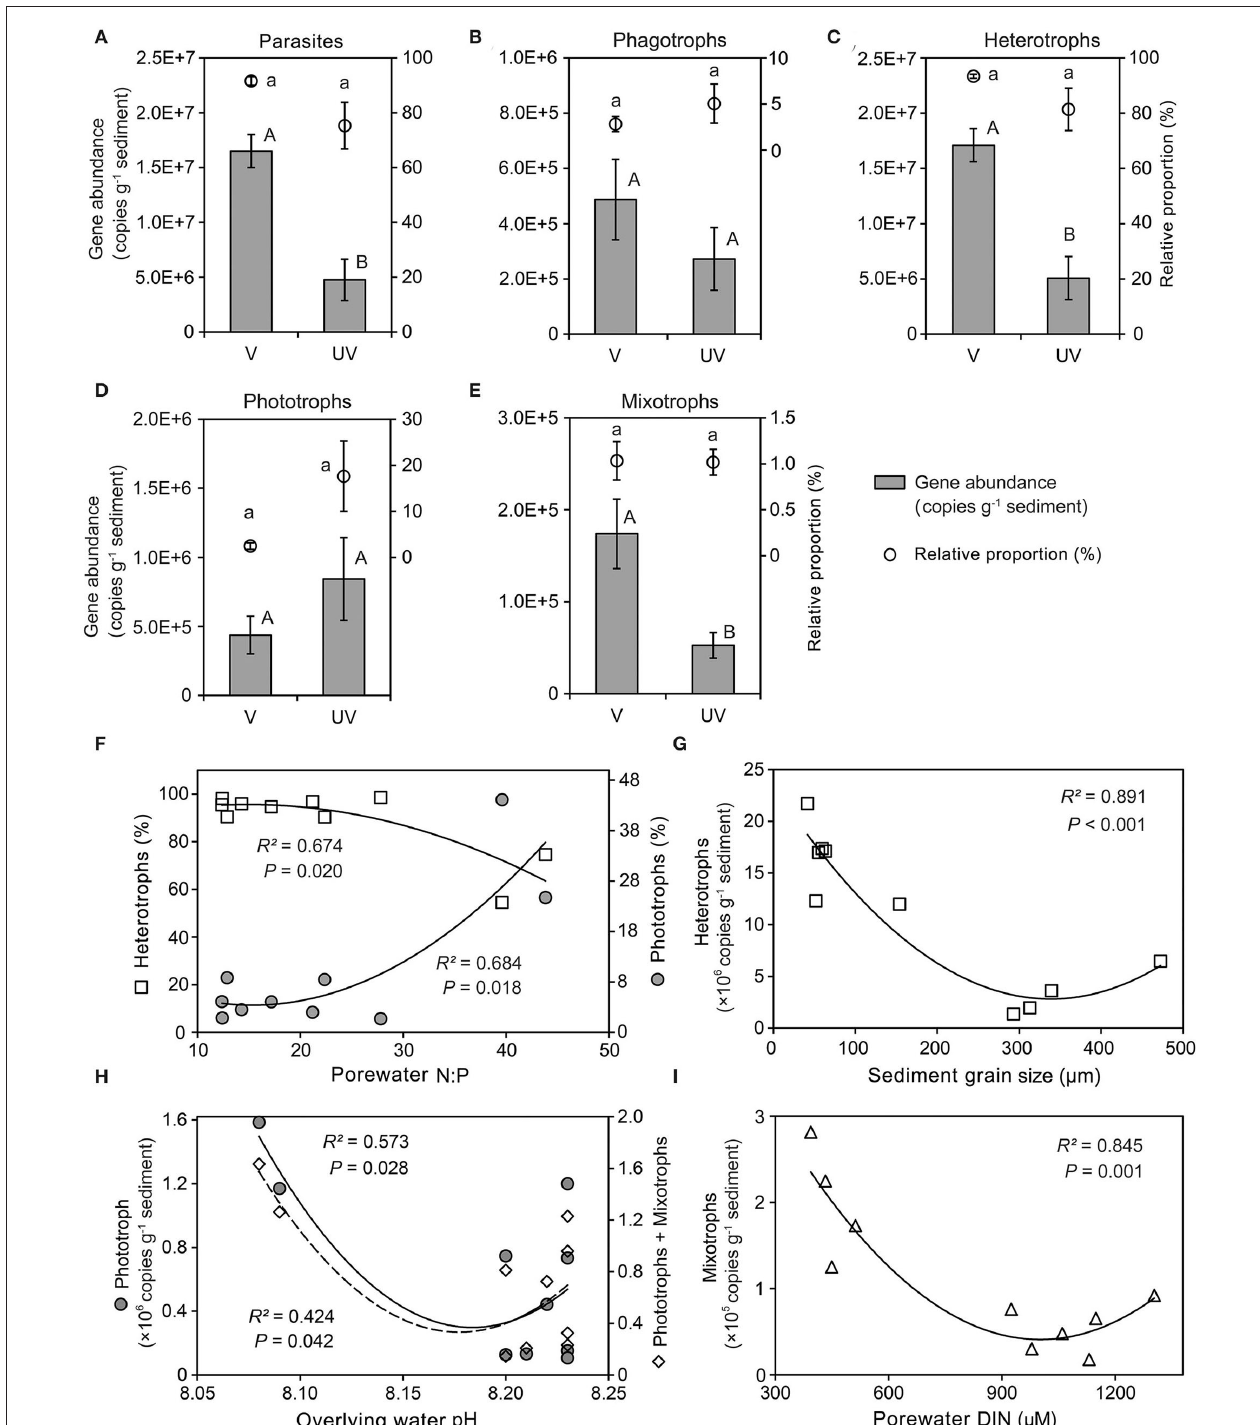
FIGURE 7 | Functional compositions of benthic eukaryotes in sediments of a seagrass system. (A–E) Comparison of the relative proportions and gene abundances of parasites (A) , phagotrophs (B) , heterotrophs (C) , phototrophs (D) , and mixotrophs (E) between vegetated and unvegetated sediments, showing that the read proportions were not significantly different for all the examined functional groups, whereas the total gene copy numbers of parasites, heterotrophs, and mixotrophs were significantly higher in the vegetated sediments; (F) the relative proportions of both heterotrophs and phototrophs were related to molar ratio of porewater inorganic nitrogen to phosphate; (G–I) the gene abundances of heterotrophs, phototrophs (also pigmented protists), and mixotrophs covaried well with sediment grain size (G) , overlaying water pH (H) , and concentration of porewater dissolved inorganic nitrogen (DIN) (I) , respectively.